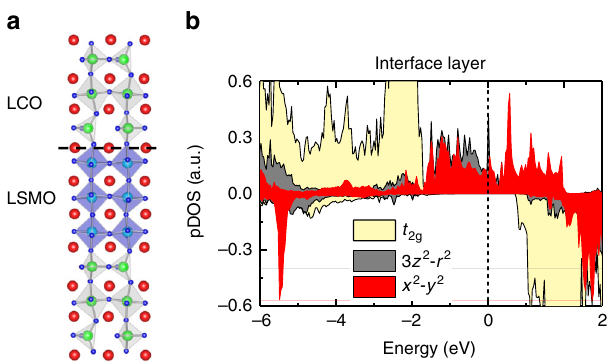
Fig. 6 Results of density functional theory calculations. a DFT calculated 3/ 3-LSMO/LCO superlattices with two CoO 4 /MnO 6 interfaces. b Projected density of Mn 3 d states of the interfacial layer. d gray, d x 2 (cid:2) y 2 in red, and t 2g in